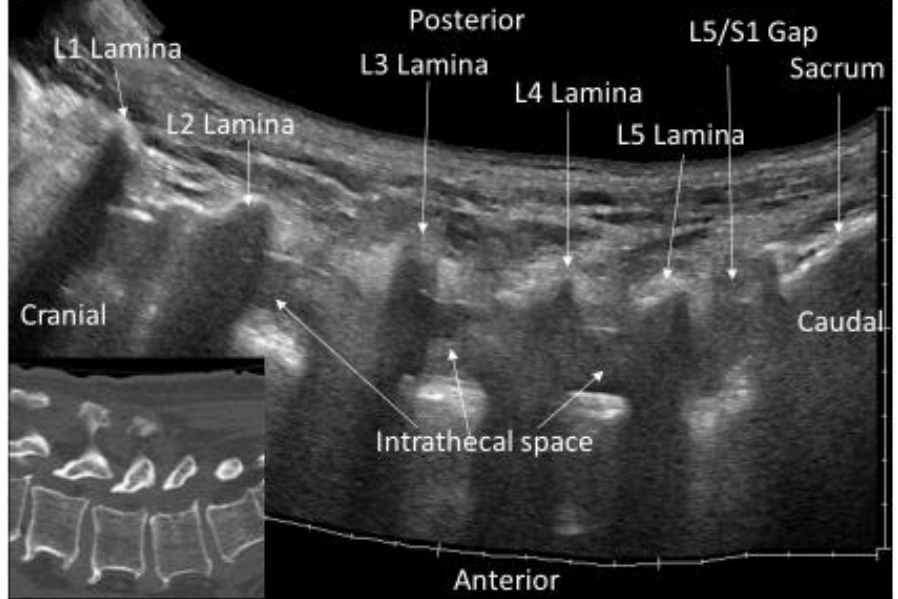
Figure 2. Panoramic paramedian sagittal oblique sonogram of the lumbar and lumbosacral junctions. The posterior surface of the sacrum was identified as a flat hyperechoic band with an acoustic shadow anterior to it. The gap between the sacrum and lamina of L5 is the L5/S1 intervertebral space. The L4/L5 and L3/L4 intervertebral spaces were identified by counting upward. The image in the inset shows the reconstruction of the computed tomography lumbar spine image. Abbreviations: L, lumbar.